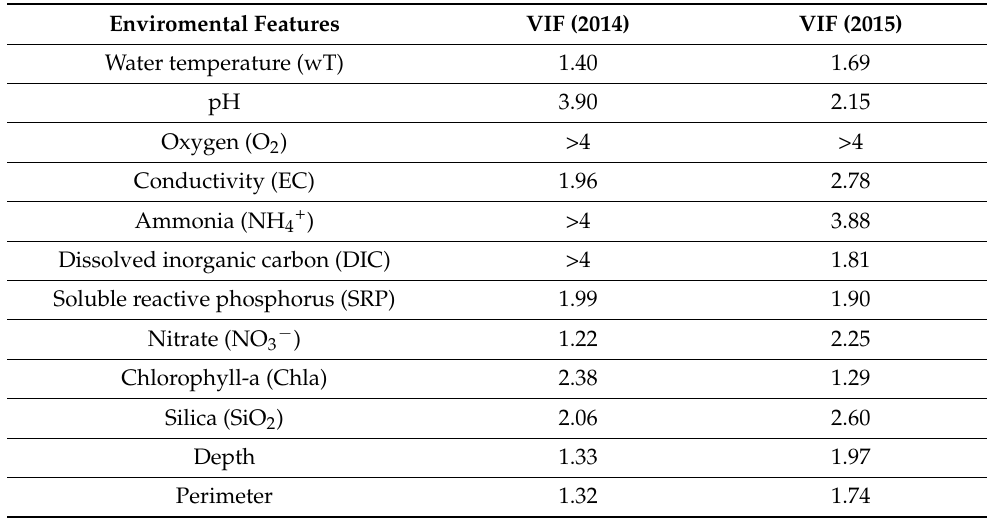
Table 1. VIF values for each chemical and physical environmental feature in 2014 and